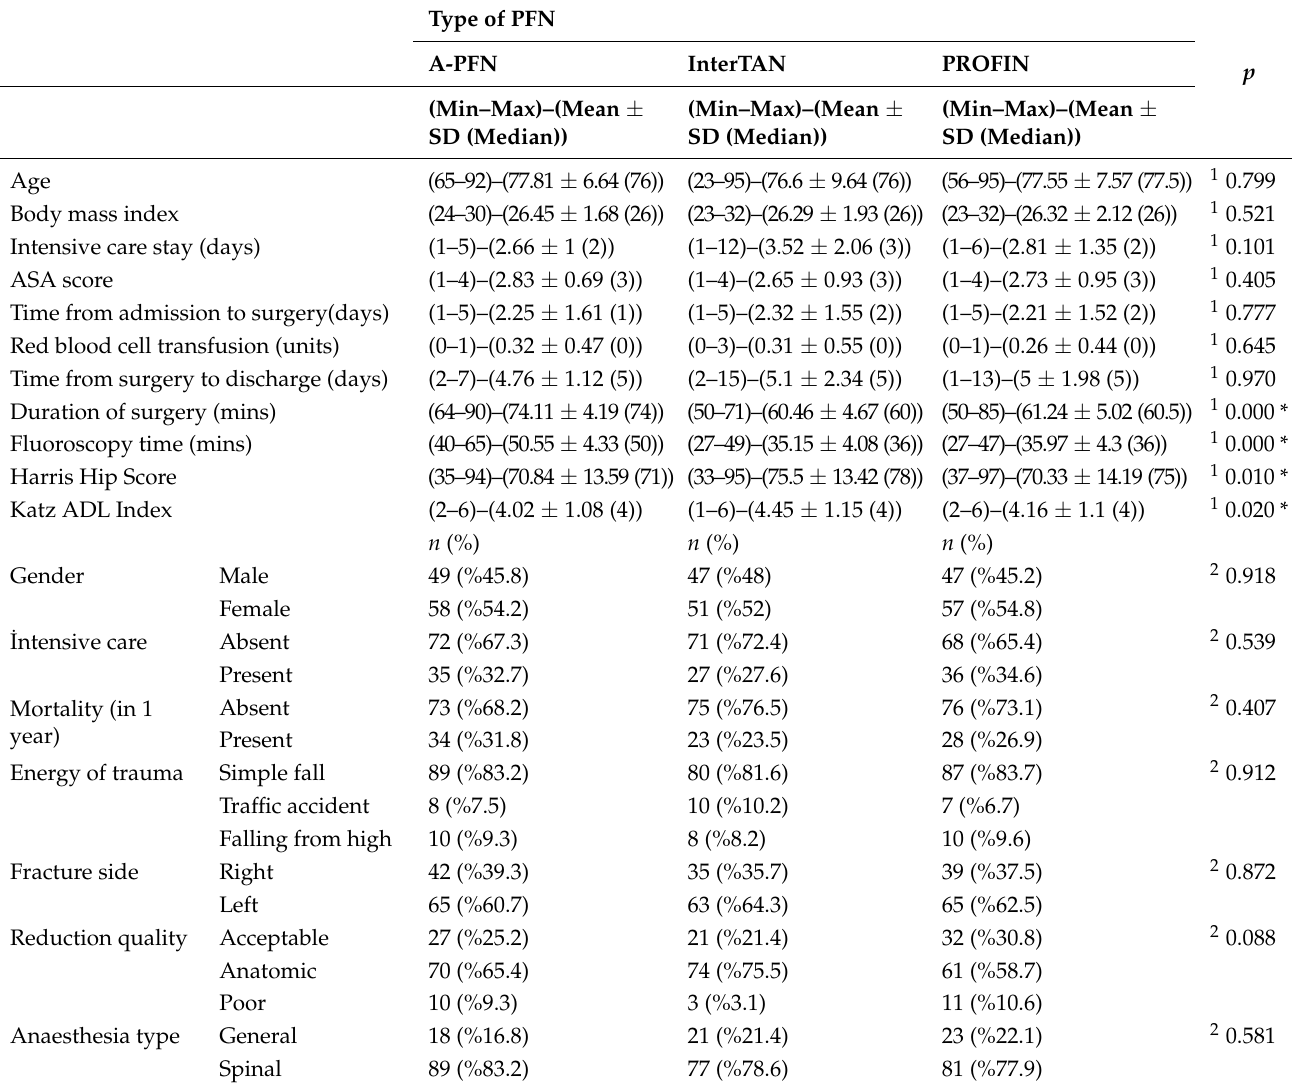
Table 4. Evaluation of general characteristics among proximal femoral nail subgroups.